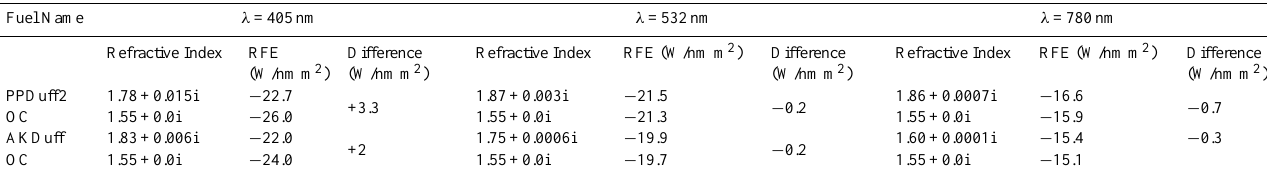
Table 2. Comparison of radiative forcing efficiency (i.e., radiative forcing per unit optical depth and bandwidth) at 405nm, 532nm, and 780nm for brown carbon emitted from Ponderosa Pine Duff and Alaskan Duff combustion with that of traditional organic